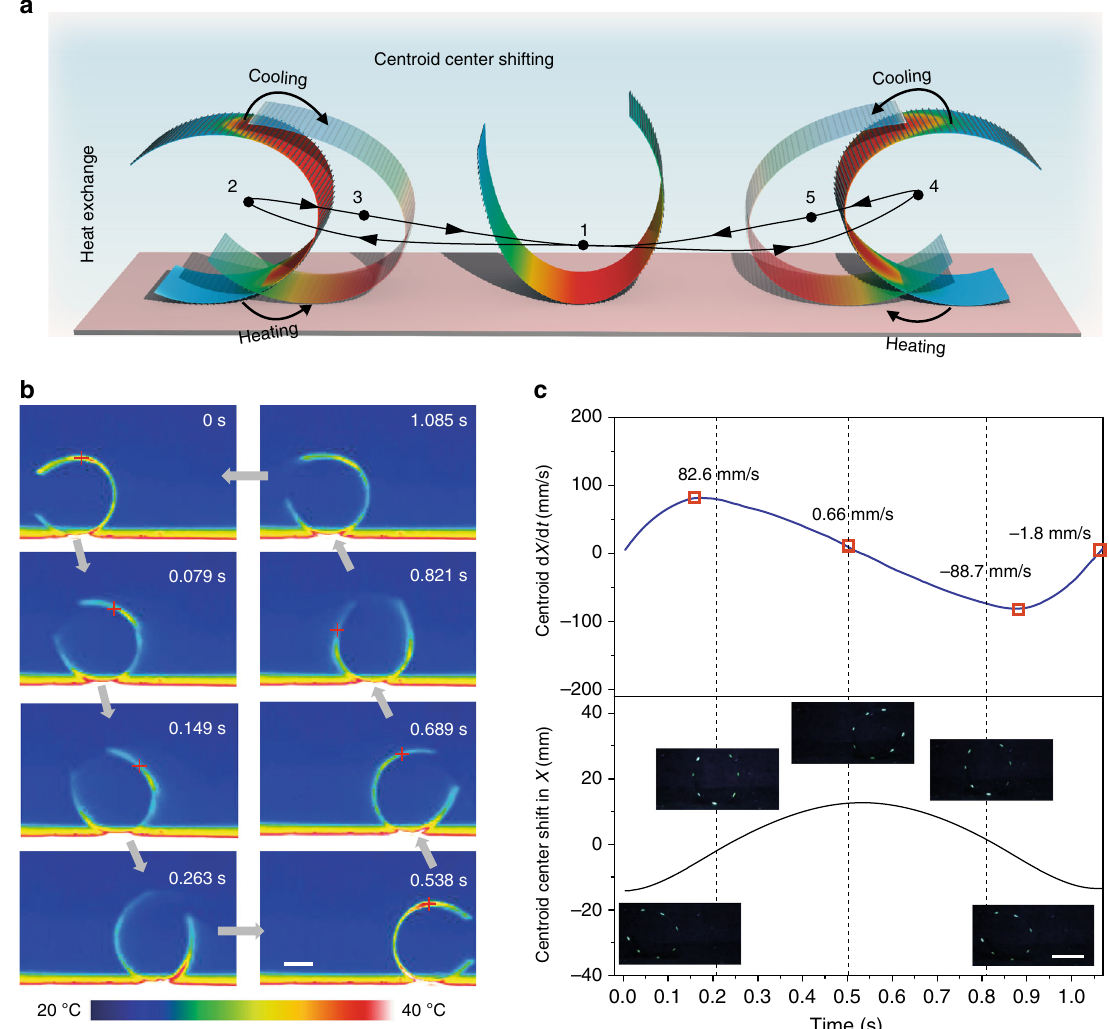
Fig. 3 Thermo-mechanical feedback mechanism for the autonomous oscillation. a Schematic illustration of the heat exchange followed by center of gravity shifting of TMES during the oscillation process. b Time-dependent infrared images. c Centroid and rate of change of centroid of TMES in the x -axis during a complete oscillation cycle at 60 °C. Insets of c are fl uorescent images of marked TMES corresponding to the oscillation positions. All scale bars correspond to 1